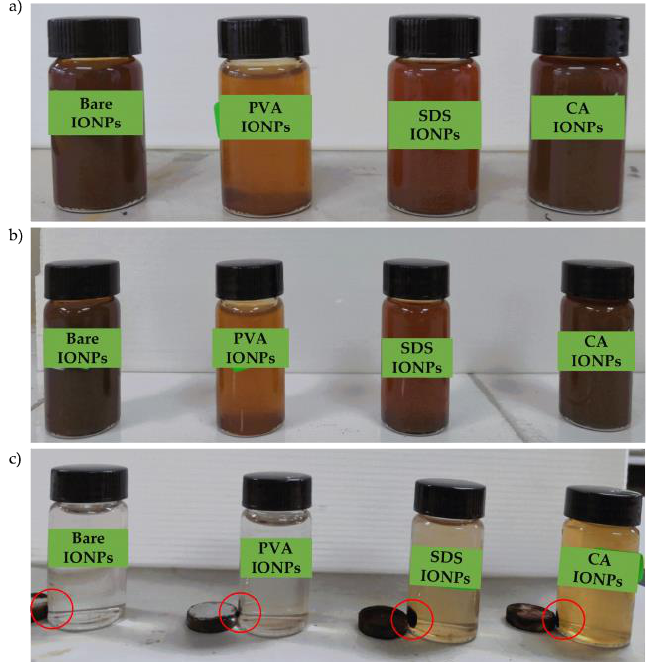
Figure 5. Photograph of aqueous suspensions of bare IONPs, PVA-IONPs, SDS-IONPs, and CA- IONPs after ( a ) 10 min, ( b ) 24 h and ( c ) separation of the nanoparticles using a permanent magnet.